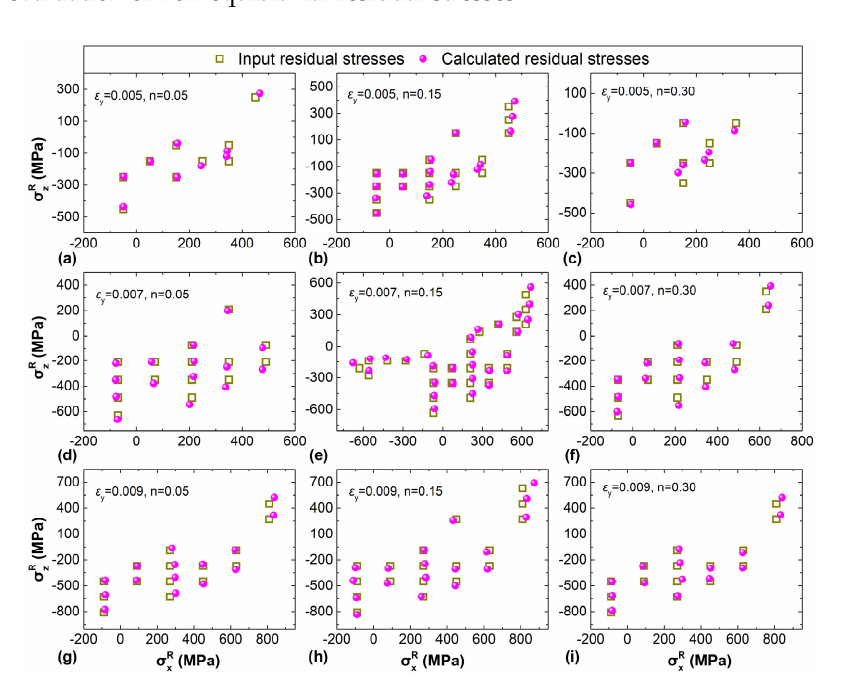
Figure 8. Comparison between the calculated residual stresses and input residual stresses: Figure8. Comparisonbetweenthecalculatedresidualstressesandinputresidualstresses: ( a ) ε y = 0.005, (a) , n = 0.05, ( b ) ε y = 0.005, n = 0.15, ( c ) ε y = 0.005, n = 0.3, ( d ) ε y = 0.007, n = 0.05, ( e ) ε y = 0.007, n = 0.15, ( f ) ε y = 0.007, n = 0.3, ( g ) ε y = 0.009, n = 0.05, ( h ) ε y = 0.009, n = 0.15, ( i ) ε y = 0.009, n =